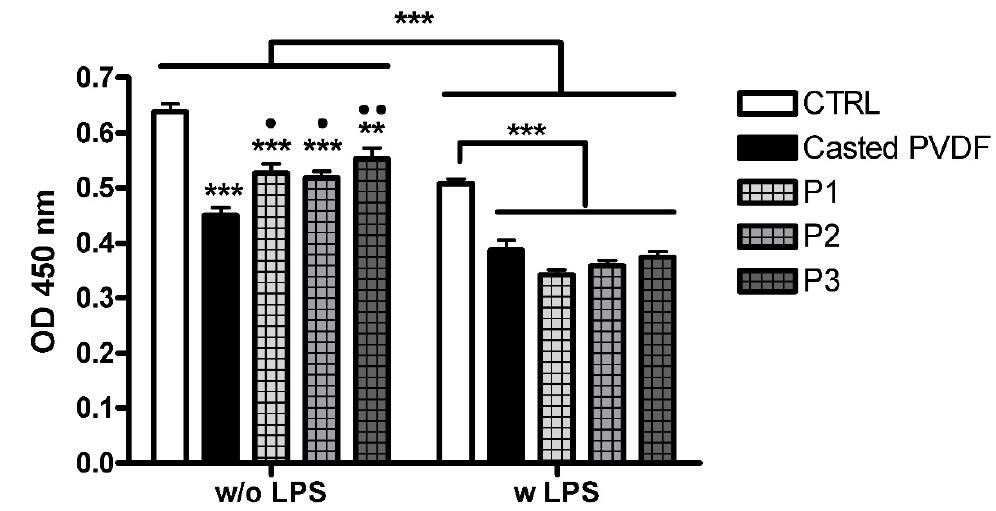
Figure 6. Effect of PVDF scaffolds on metabolic activity in LPS-activated and inactivated THP-1-differentiated macrophages cells. Cells cultured on glass coverslip and treated with cell assay medium served as negative controls (CTRL). Data are shown as mean ± standard deviation values of triplicates in each group. *** p < 0.001, ** p < 0.01 vs. CTRL, •• p < 0.01, • p < 0.05 vs. Casted surfaces .